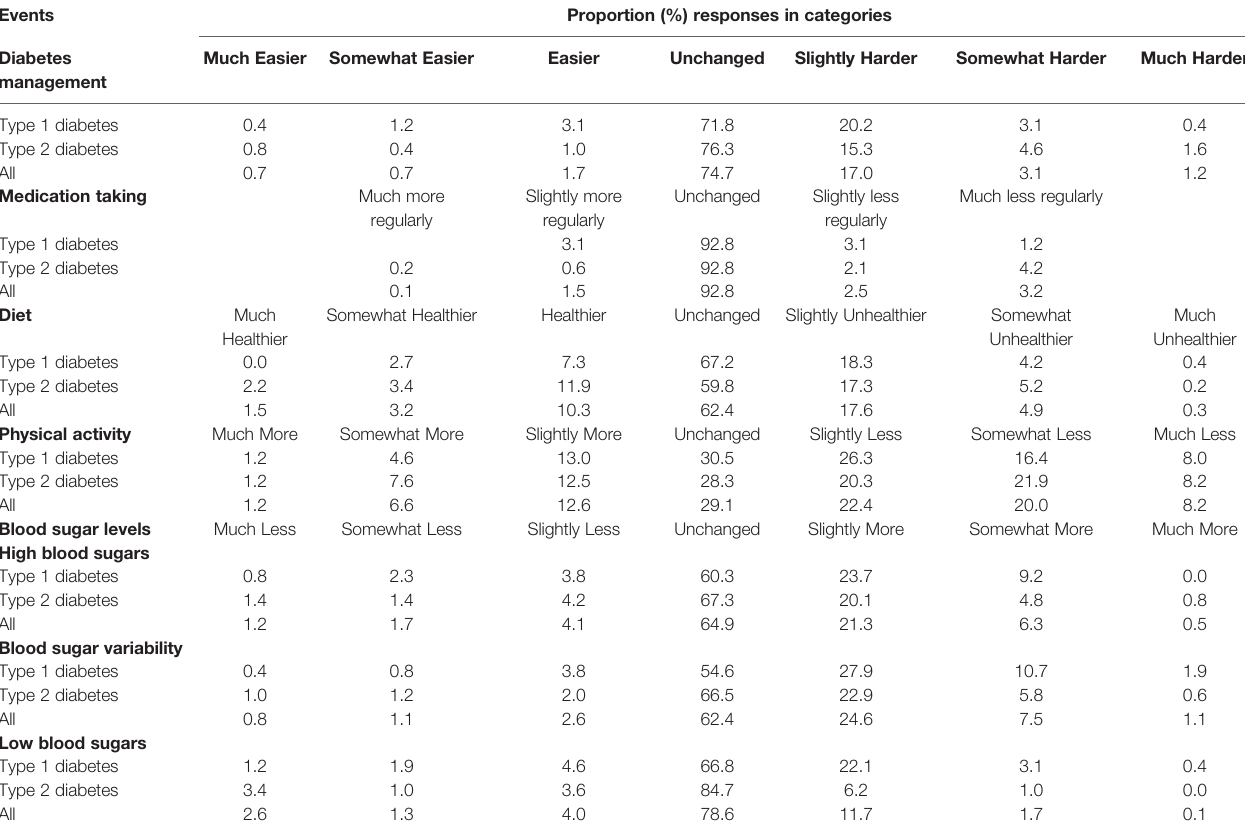
TABLE 2 | Self-reported changes in diabetes self-management behaviors. Events Proportion (%) responses in categories Diabetes